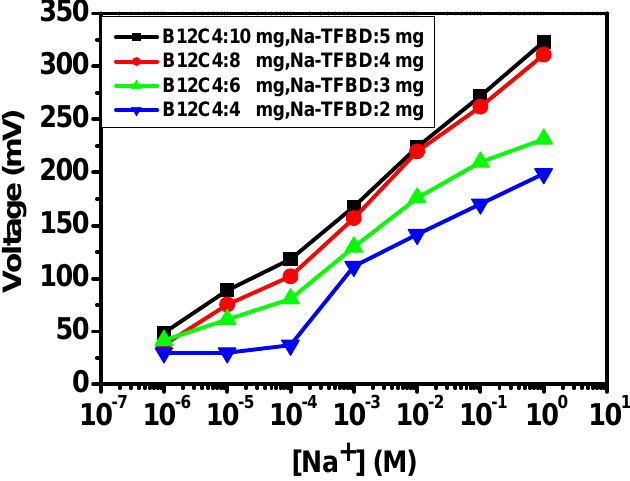
Figure 6. Sodium-sensing sensitivity of sodium-selective-membrane/anodized-ITO/ITO with four ratios of selective membrane.